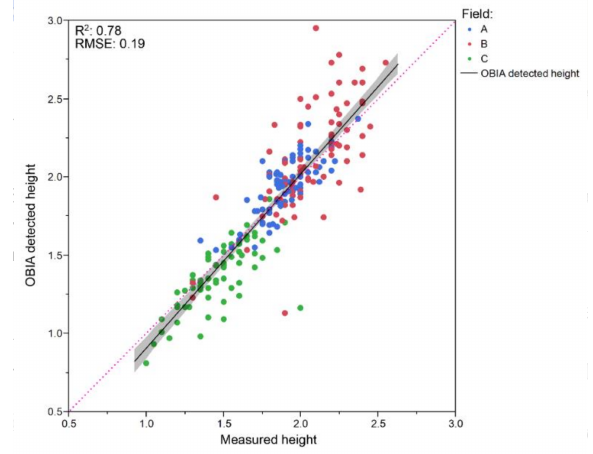
Figure 6. Graphic comparing DSM-OBIA estimated and vine height for all data corresponding to the three fields and both dates (July and September). The root mean square error (RMSE) and correlation coefficient ( R 2 ) derived from the regression fit are included ( p < 0.0001). The solid line is the fitted linear function and the pink dashed line represents the 1:1